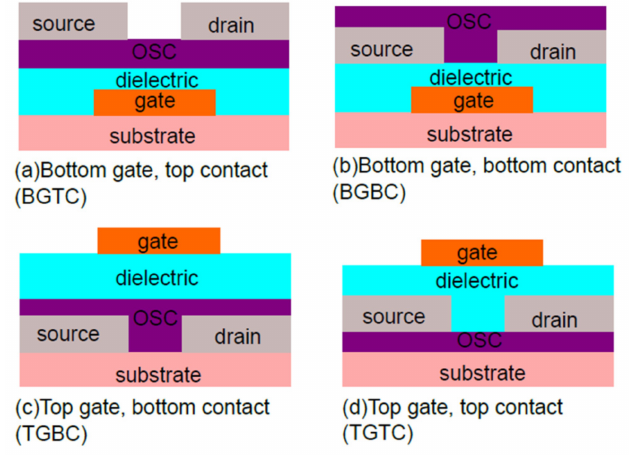
Figure 4. Different geometrical configurations of an OFET. ( a ) Bottom gate, top contact, ( b ) Bottom gate, bottom contact, ( c ) Top gate, bottom contact, ( d ) Top gate, top contact OFET. The dielectric layer behaves like a capacitor between gate and source-drain elec-